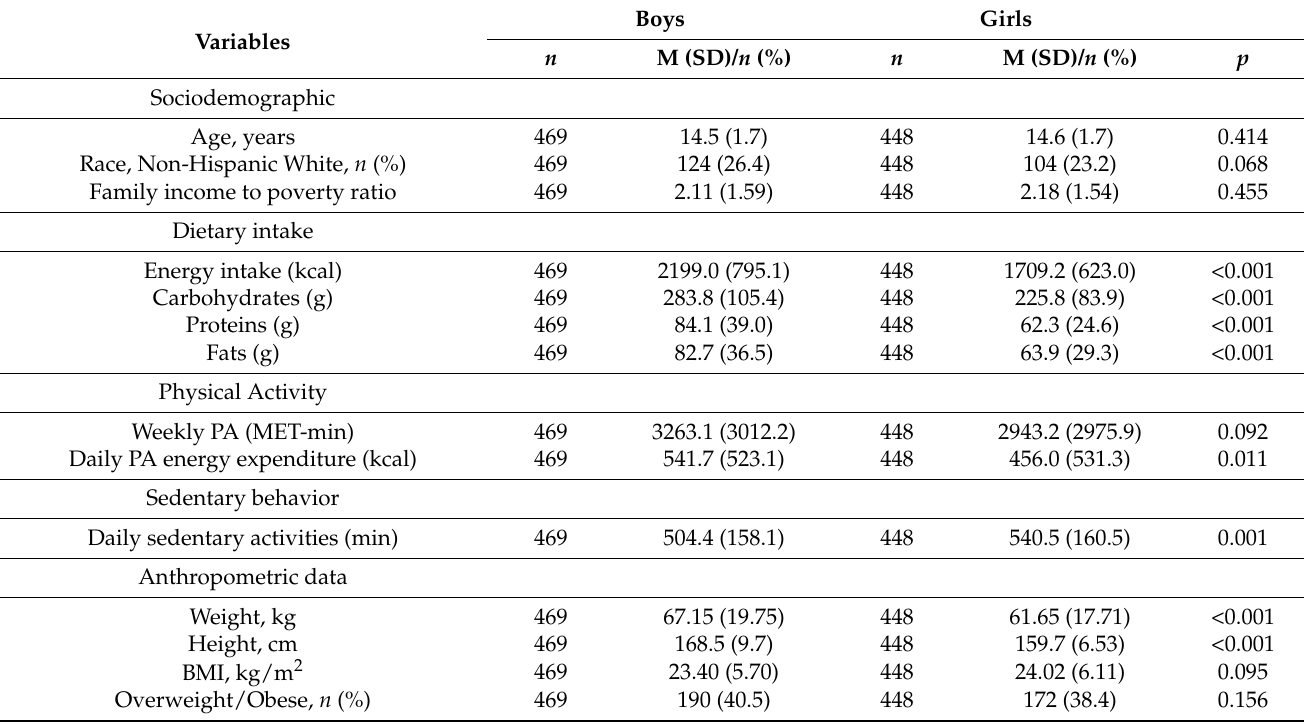
Table 1. Participants’ characteristics of the analyzed sample ( n =